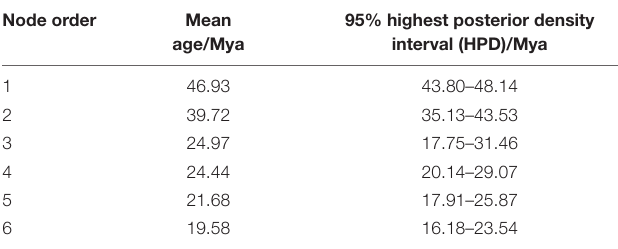
TABLE 1 | Estimated ages for the major nodes of Populus . Node order Mean